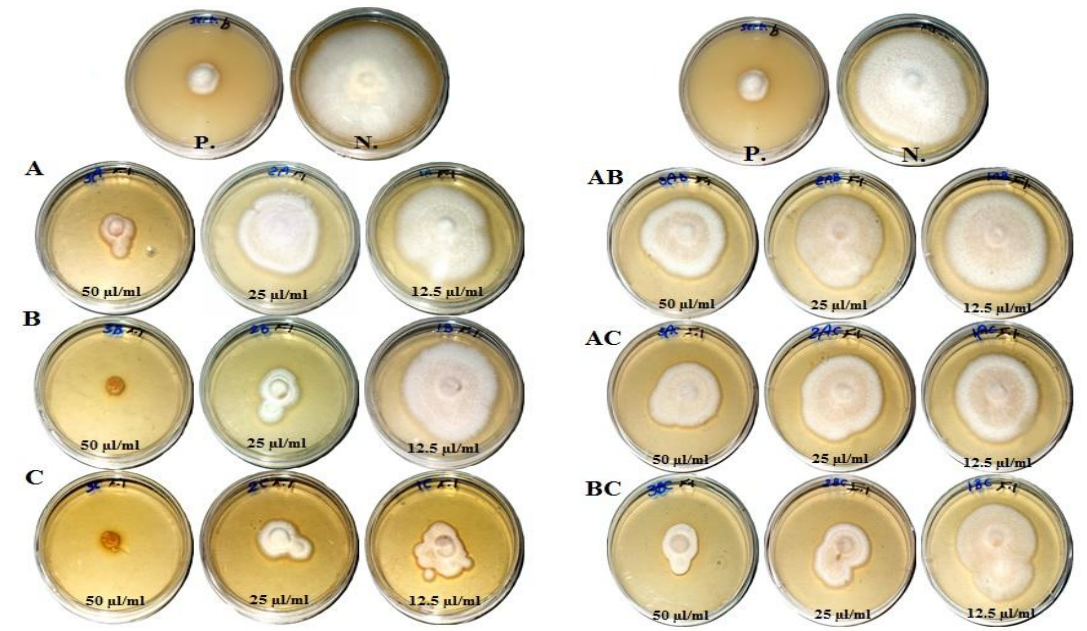
Figure 5. Visual observation of F. culmorum growth inhibition as affected by the EOs from ( A ) C. aurantium oil, ( B ) E. camaldulensis oil, and ( C ) C. sinensis oil and their combinations. ( P ) Positive control (Sertaconazol 3 g / L). ( N ) Negative control (DMSO 10%). ( A , B ) C. aurantium oil + E. camaldulensis oil. ( A , C ) C. aurantium oil + C. sinensis oil. ( B , C ) E. camaldulensis oil + C. sinensis